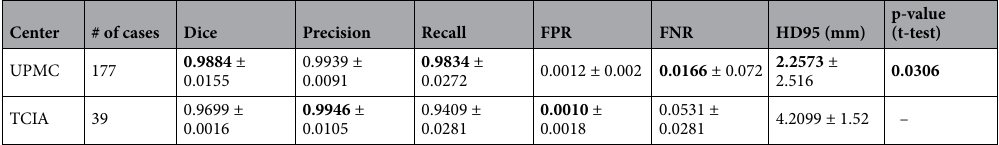
Table 4. Skull stripping performance across multicenter (UPMC and TCIA). The best result is highlighted in bold.